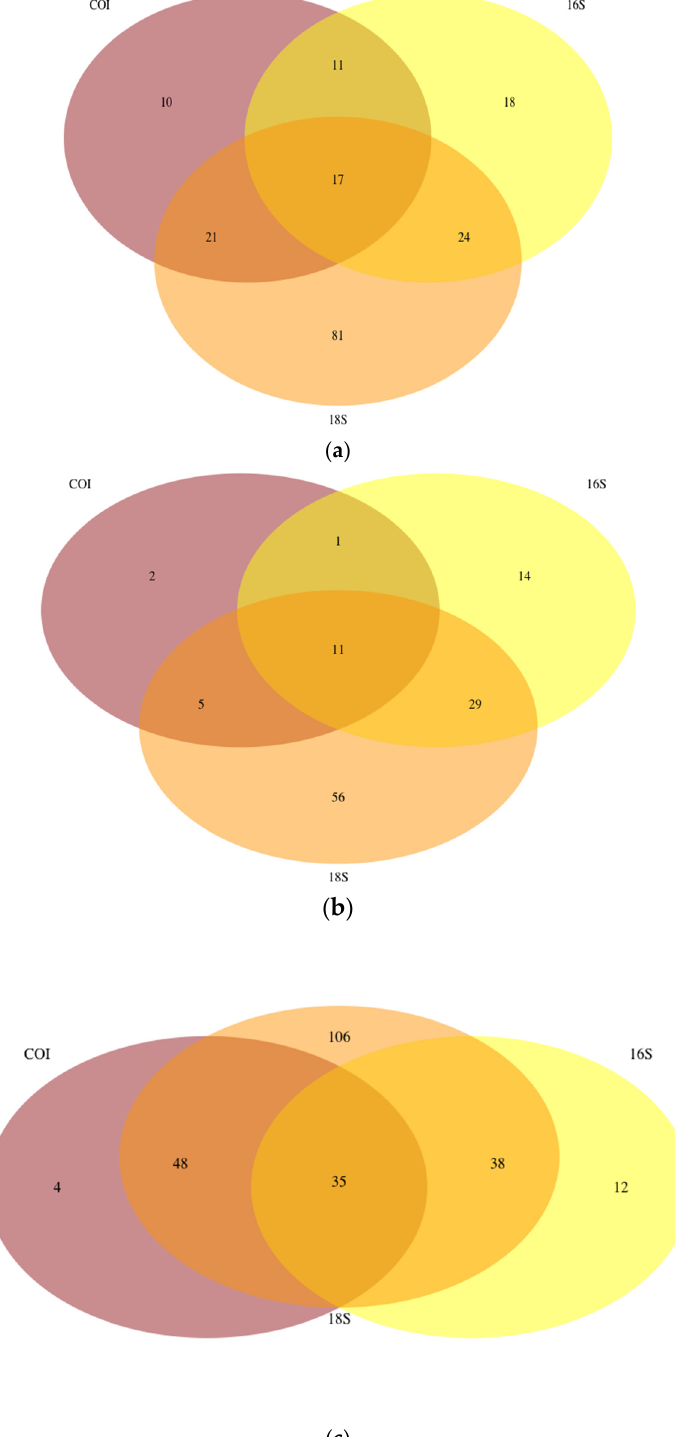
Figure 4 . Overlap of species with DNA barcode for the three markers (COI, 16S, and 18S) from transitional waters ( a ), lakes ( b ), and marine coastal waters ( c ).